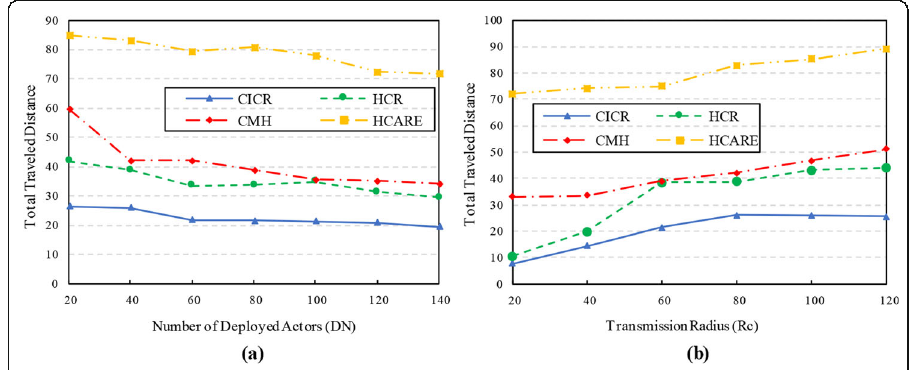
Fig. 6 The total traveled distance with varying ( a ) the number of actors (fixed R c = 80), ( b ) the transmission radius (fixed DN = 40)